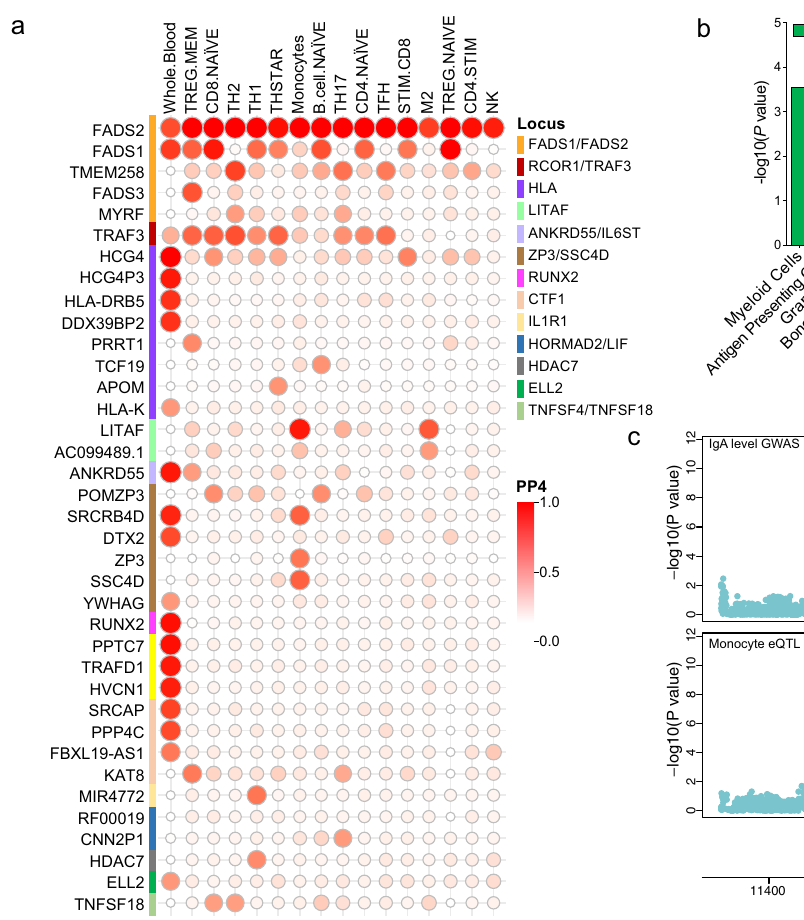
type annotations. c Integrative analysis of eQTL and hQTL for LITAF locus. The upperandlowerpanelsshowtheregionalplotsofthe LITAF locusforIgAGWASand eQTLs in monocyte, respectively. The y -axis represents the − log10 of the unad- justed two-sided p -value for the fi xed effects GWAS meta-analysis (top) and the Wald test fromlinearregressionof genotypeongene expression level(bottom); x - axis shows the chromosome positions. The lowest panel denotes the positions of LITAF gene and a hQTL peak (H3K27ac) in